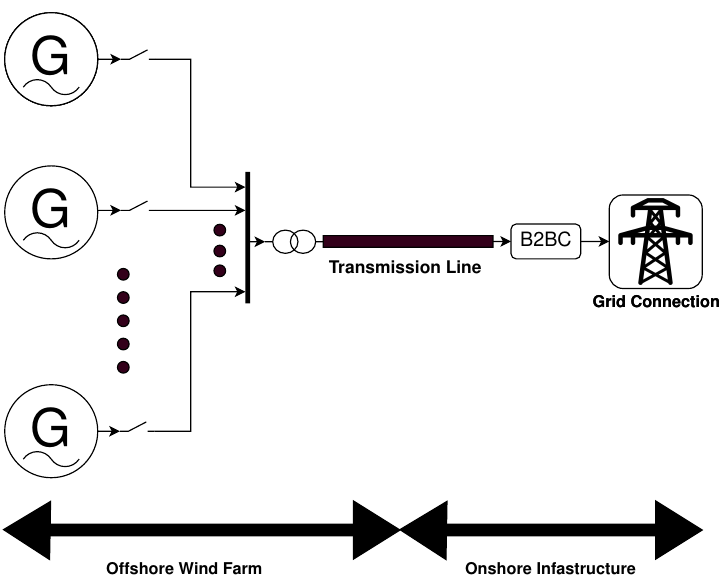
Figure 2. Direct